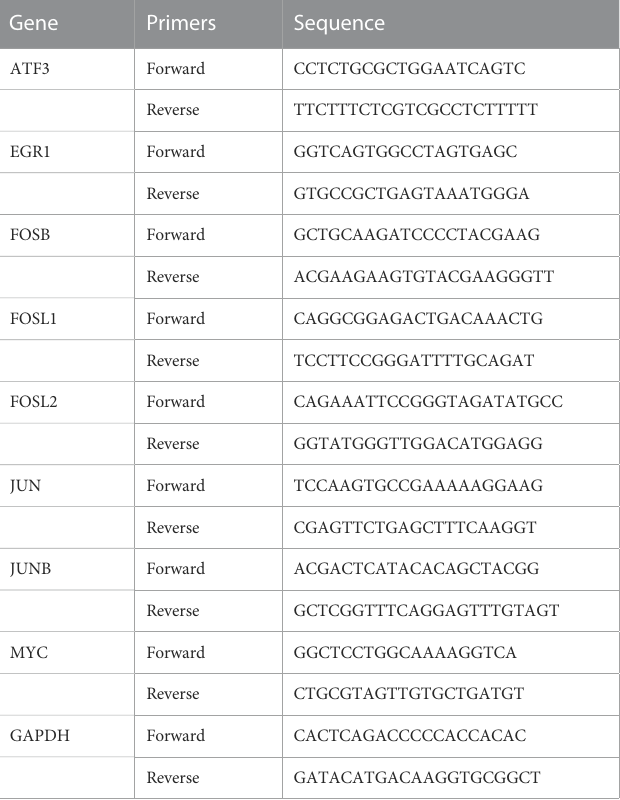
TABLE 1 Primers used for RT-qPCR ampli fi